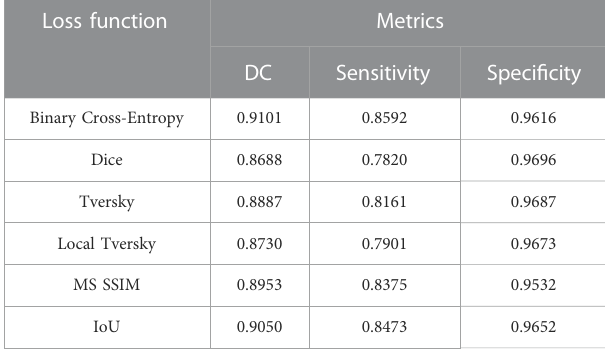
TABLE 1 Evaluation metrics by using different loss